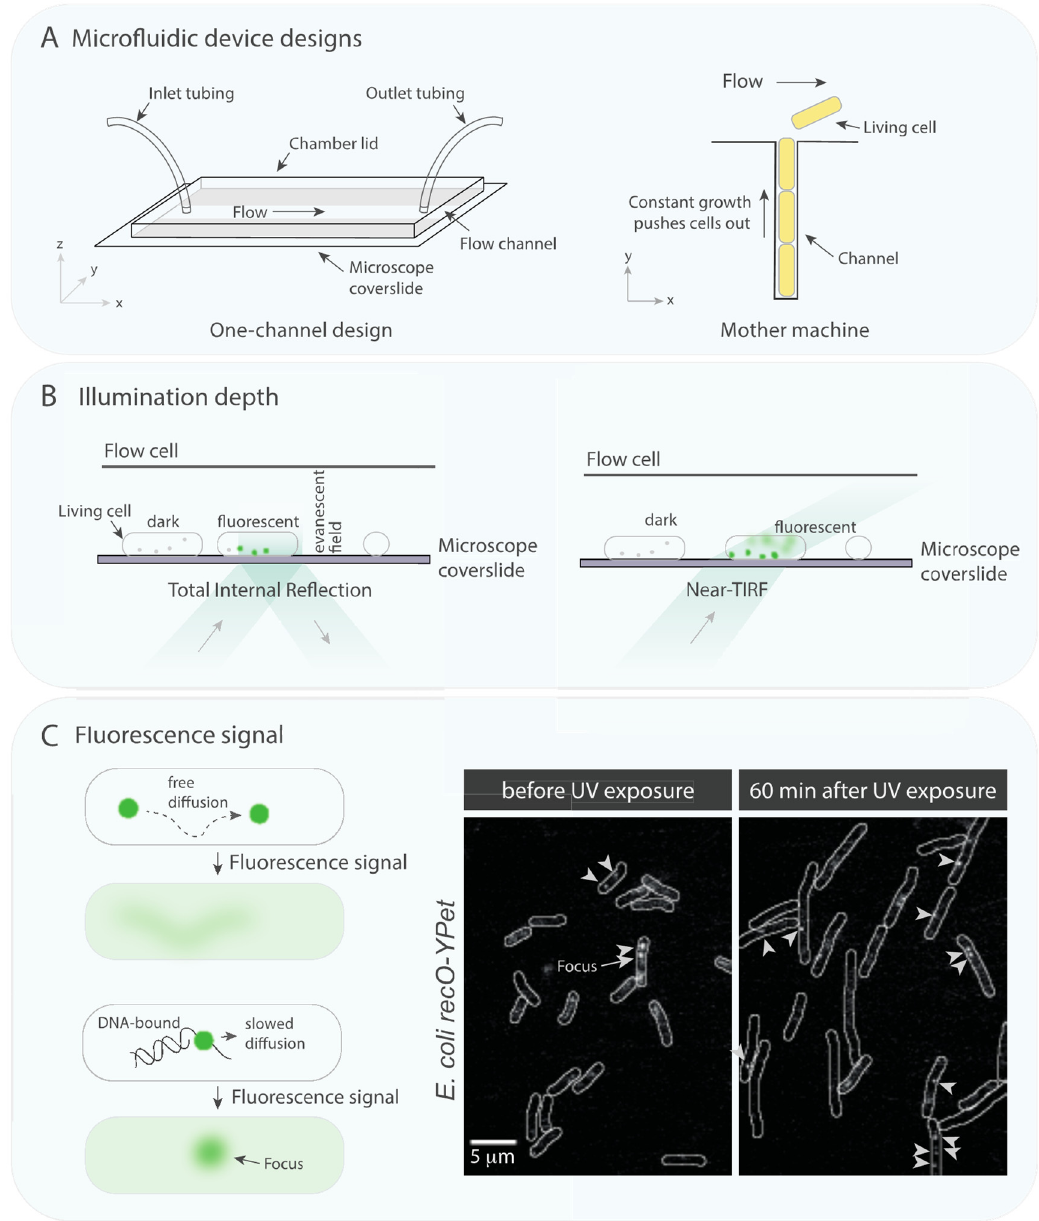
Figure 2 . In vivo single-molecule fluorescence tools. ( A ) Two designs of microfluidic devices to hold cells for live-cell imaging. Left : simple single-flow channel device where cells can be immobilized on derivatized surface using, i.e., (3- aminopropyl)triethoxysilane. Right : mother machine design [95] where cells are captured in a channel orthogonal to the flow channel, allowing to follow a single-cell during its cell cycle or in response to exogenous DNA damage. ( B ) Left : Total internal reflection fluorescence (TIRF) microscopy excites fluorophores in the evanescent field, close to the coverslip. Right : Near-TIRF setting allows excitation deeper into the cells, additionally capturing fluorescently tagged proteins further away from the coverslip, making it more suitable to follow proteins of interest in living cells. ( C ) Proteins that are not bound to DNA diffuse faster than proteins that are bound to the larger genome. The difference in diffusion behavior can be captured when imaging fluorescently tagged proteins in living cells. At video rate, the fluorescence signal of a freely diffusing protein appears as a blur, whereas the signal of DNA-bound proteins shows static foci. The figure shows exemplary fluorescence datcells before and 60 min after UV irradiation [21]. Some foci are pointed out with white arrows.